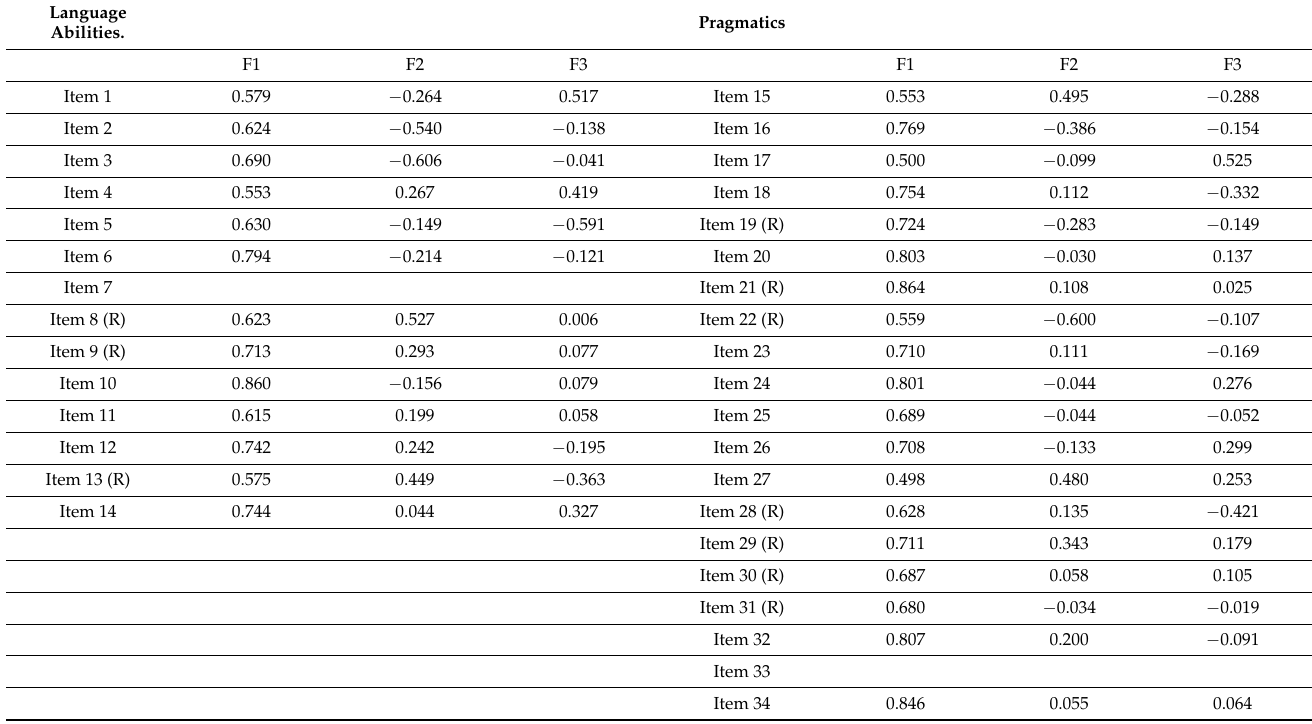
Table 3. Factor Loadings: grey highlighting indicates